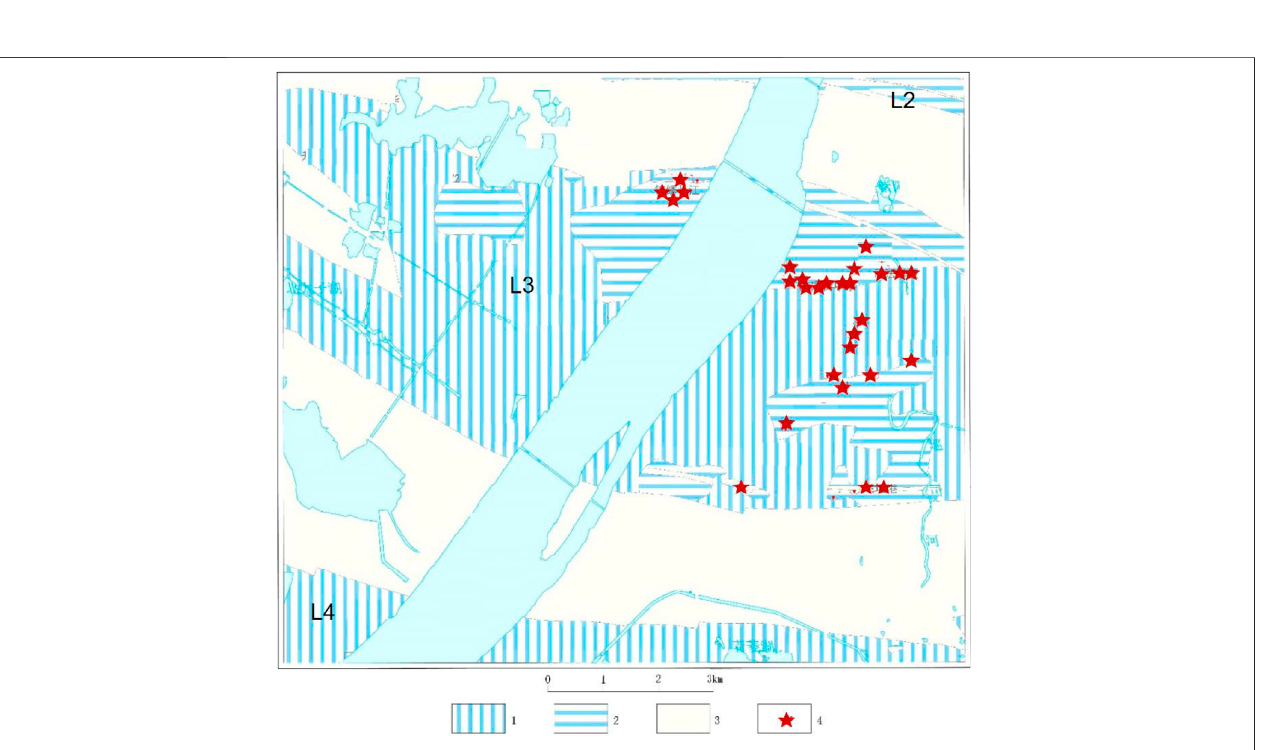
FIGURE 3 | Distribution of karst ground collapse in the study area. 1. Buried karst area; 2. Covered karst area; 3. Nonsoluble rock area; 4. Karst collapse.